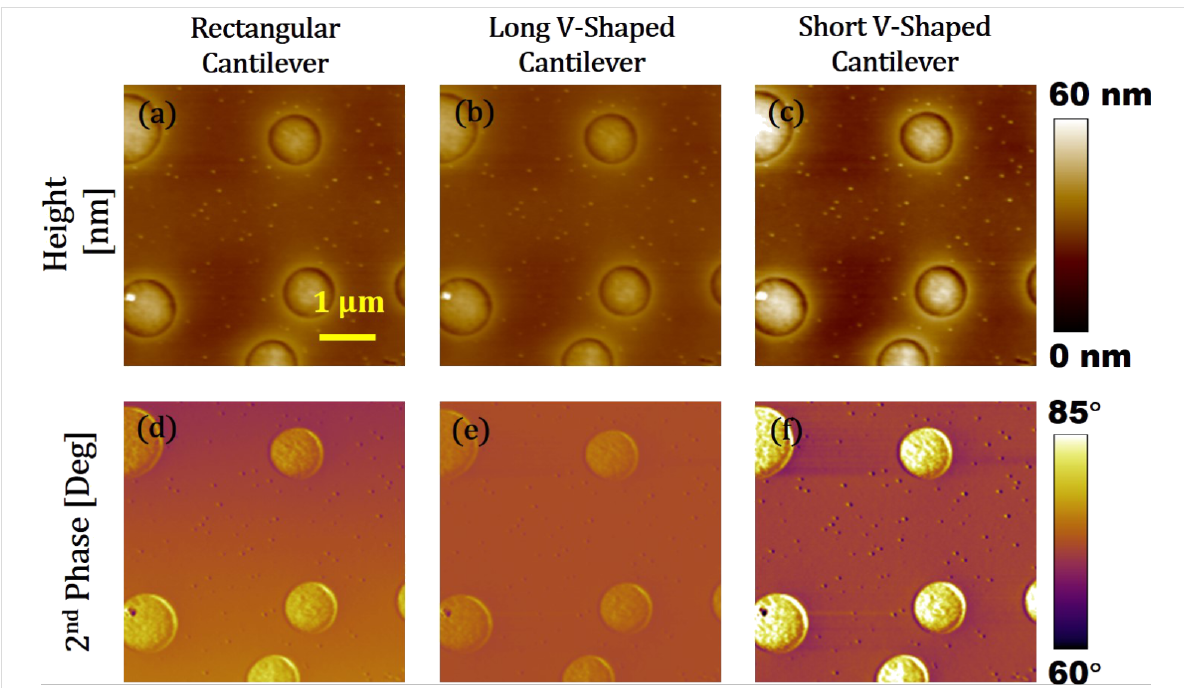
Figure 14: Bimodal AFM images of PS-LDPE samples. Left column: MULTI75G, middle column: TR400Long, right column: TR400Short. (a), (b), and (c) are height images. (d), (e), and (f) are phase images. All images were recorded at the same spot with a scan rate of 1 Hz, a setpoint ratio of 65%, a first eigenmode amplitude of A 1 = 10 nm, and A 2 = 2 nm. The gain was adjusted to maintain the quality of the images. The image size is 5 µm times 5